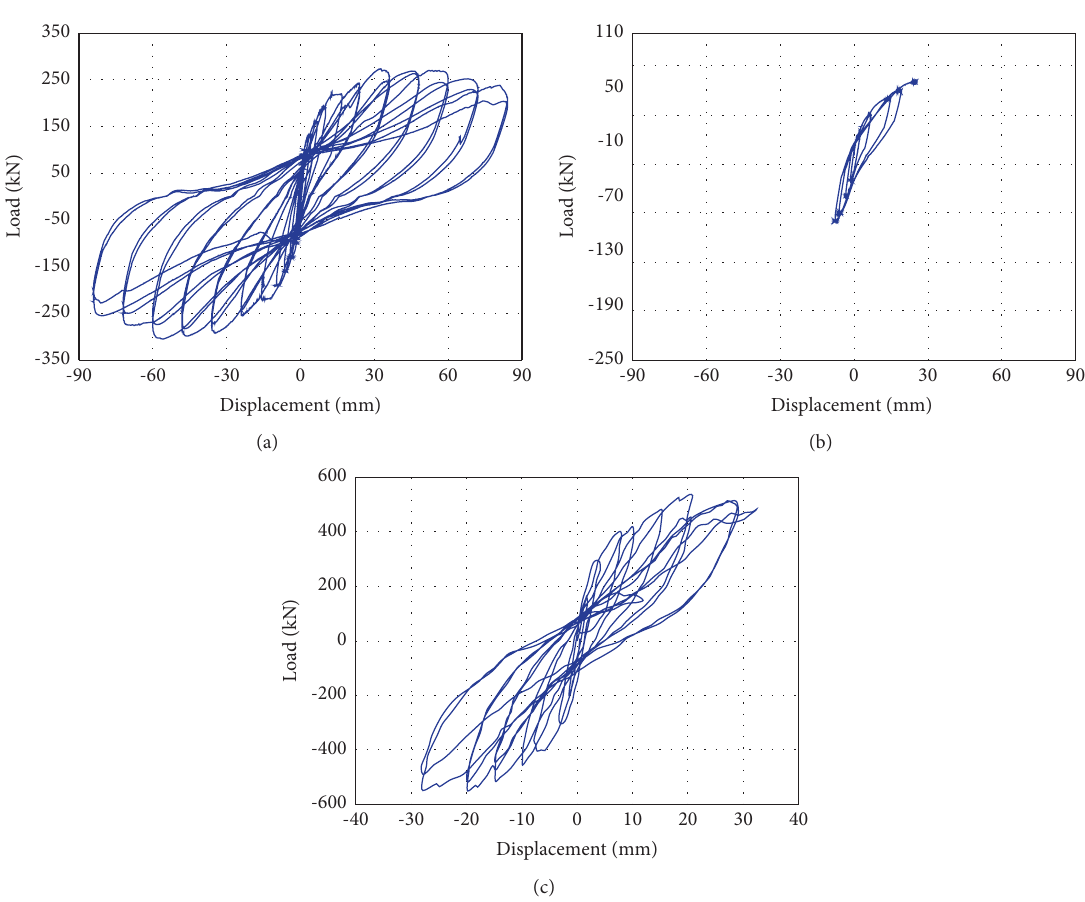
Figure 5: Horizontal load-displacement hysteresis curve of loading point: (a) middle joint; (b) side joint; (c) overall structure.